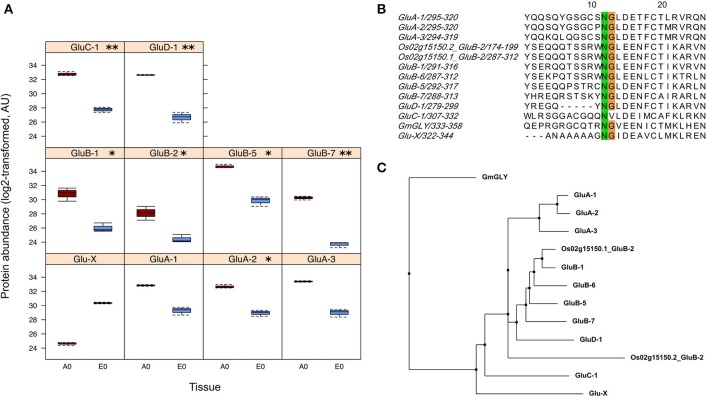
Identification of a putative new glutelin with a preferential embryo accumulation. (A) Boxplots of protein abundances (log2 transformed) for the 10 glutelins that are commonly detected in the endosperm (A0, dark red) and the embryo (E0, blue). The Glu-X protein corresponds to a newly discovered glutelin which is the only glutelin more abundant in the embryo although not significantly. Significantly different means are indicated according to the z-score analysis with p-values inferior to 0.01 (**) or 0.05 (*). (B) Close-up view of the conserved cleavage site of glutelin precursor into acidic and basic subunits. The GluC-1 protein sequence does not exibit the characteristic NG motif. (C) Phylogenetic tree built from the 12 glutelin protein sequences together with the newly putative Glutelin, namely Glu-X (neighbor joining, BLOSUM62 matrix)